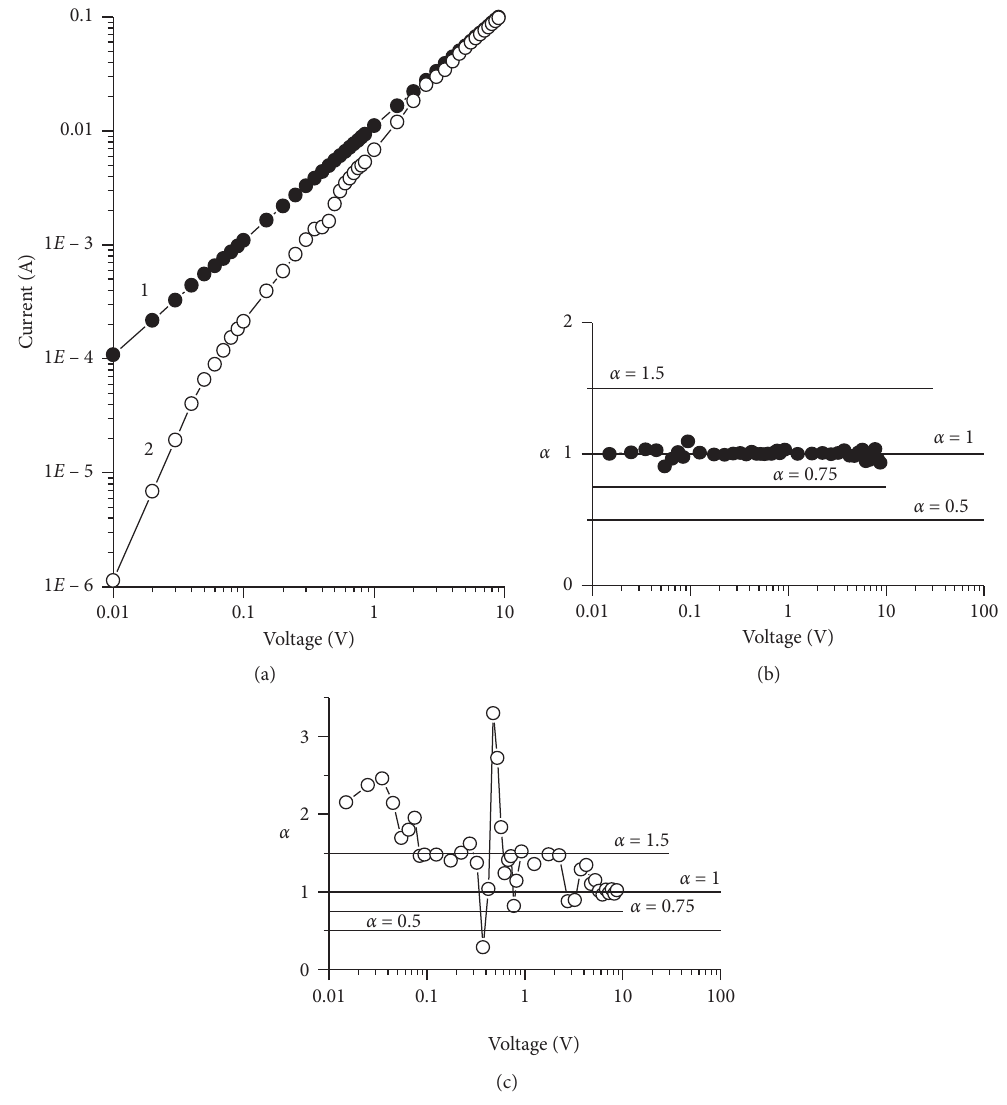
Figure 7: I-V characteristics (a) and their dimensionless sensitivity (b, c) of the TiO2/5ZnO sample: 1-in the dark (b) and 2-under illumination